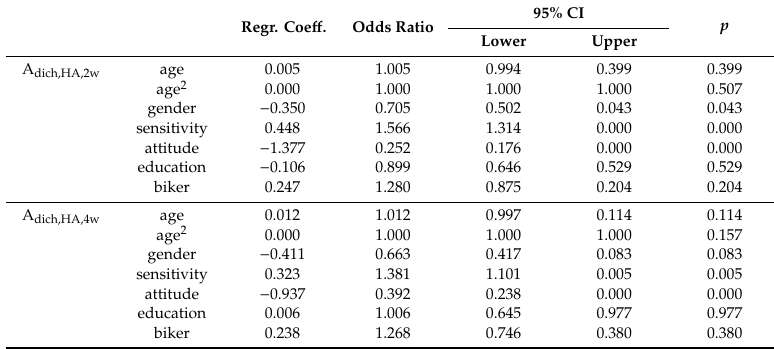
Table 7. E ff ect of Noise level in di ff erent time frames, noise sensitivity and attitude to motorcycles on annoyance in multivariate models binary logistic regression due to the influence of road tra ffi c background noise as p -values. Parameter B